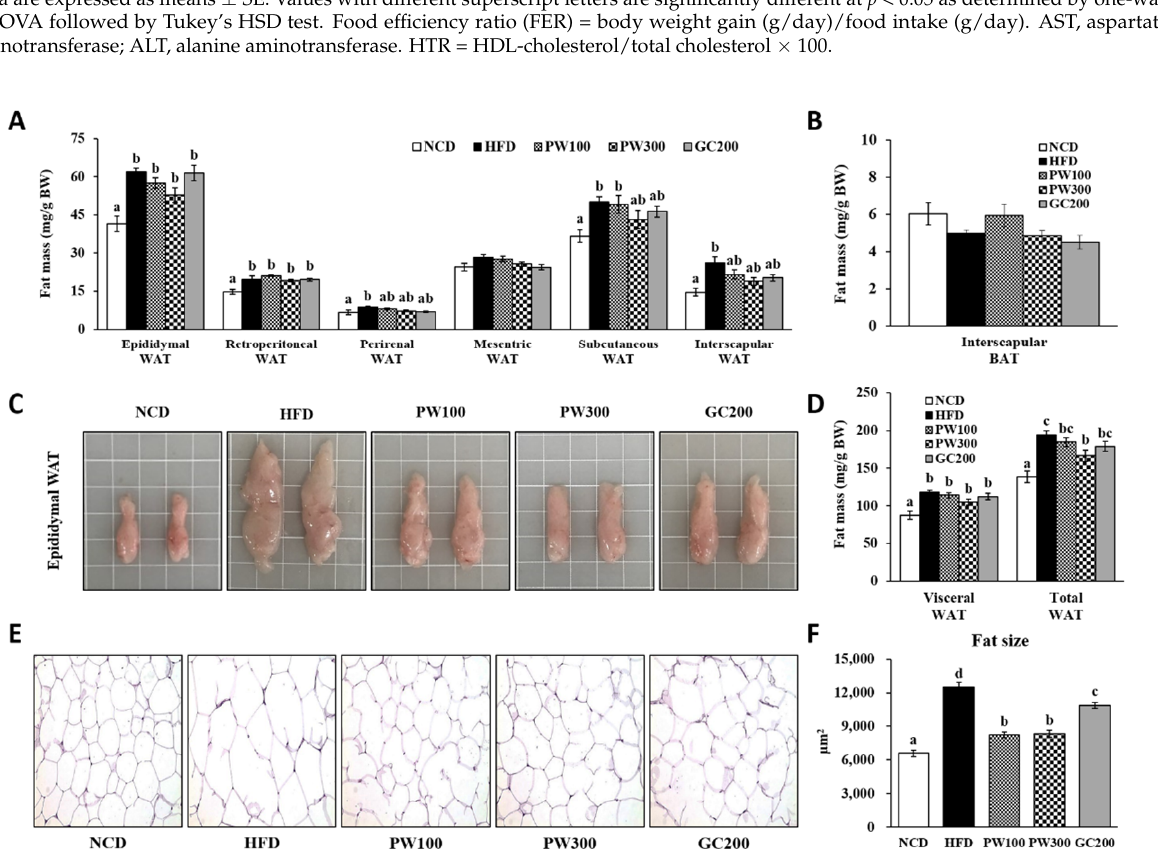
Figure 1. Effects of Polygonum multiflorum Thunb. hot water extract on WAT weights ( A ), BAT weight ( B ), representative photographs of epididymal WAT ( C ), visceral and total WAT weights ( D ), H&E microscopic images of epididymal WAT ( E ), fat size of epididymal WAT ( F ) in HFD-induced obese mice. Data are expressed as means ± SE. Values with different superscript letters are significantly different at p < 0.05 as determined by one-way ANOVA followed by Tukey’s HSD test. Magnifications × 200. WAT, white adipose tissue; visceral WAT, the sum of epididymal WAT, retroperitoneal WAT, perirenal WAT, and mesenteric WAT; total WAT, the sum of visceral WAT, subcutaneous WAT, and interscapular WAT; BAT, brown adipose tissue.